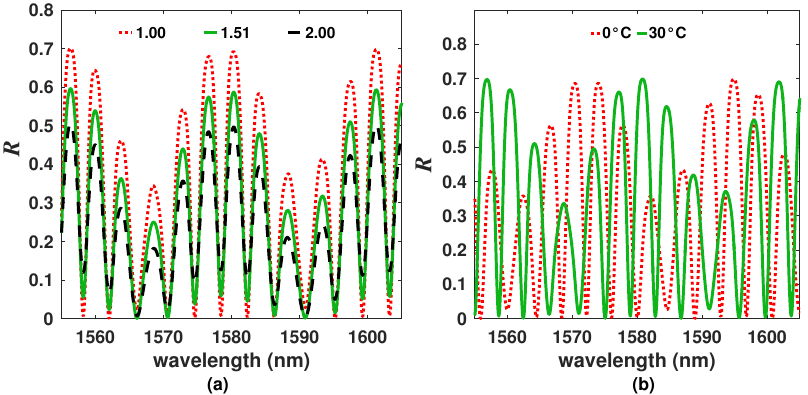
Figure 3. ( a ) Simulated intensity distribution of the reflected spectrum ( R S ) considering different n 4 values and T = 25°C, and ( b ) simulated spectrum for n 4 = 1 and different T